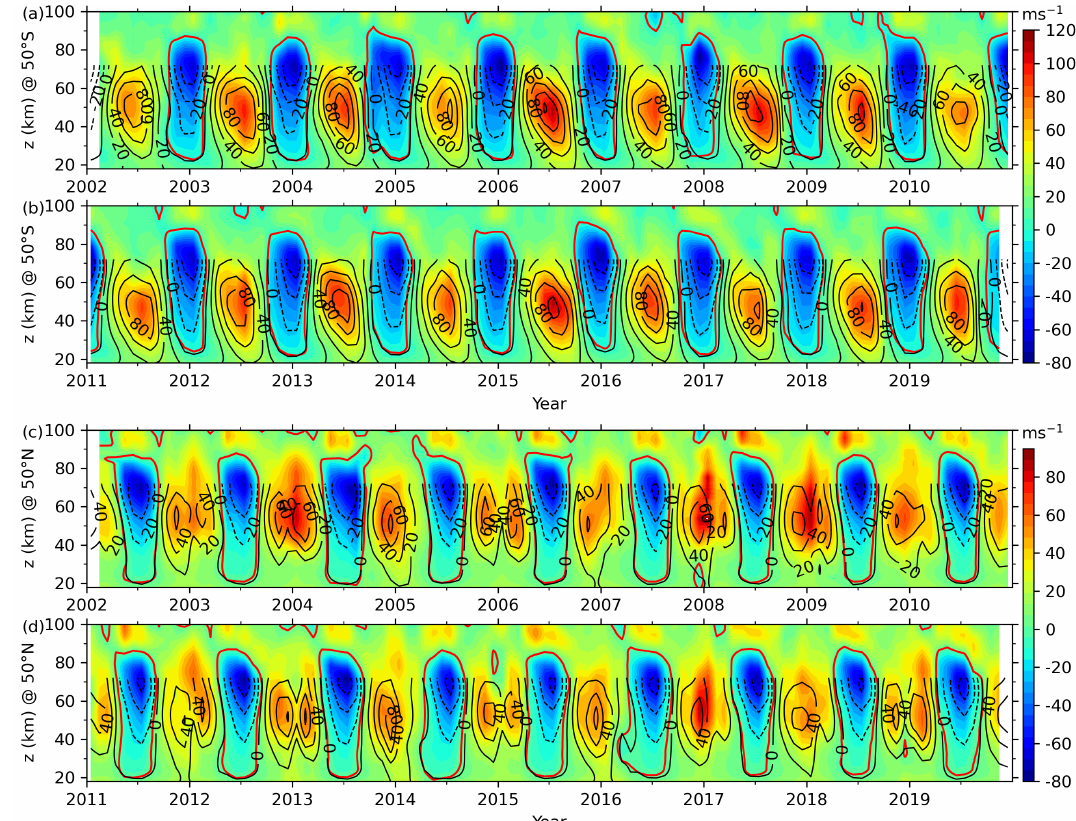
Figure 4. The same as Fig. 3 but at 50 ◦ S (a, b) and 50 ◦ N (c, d)